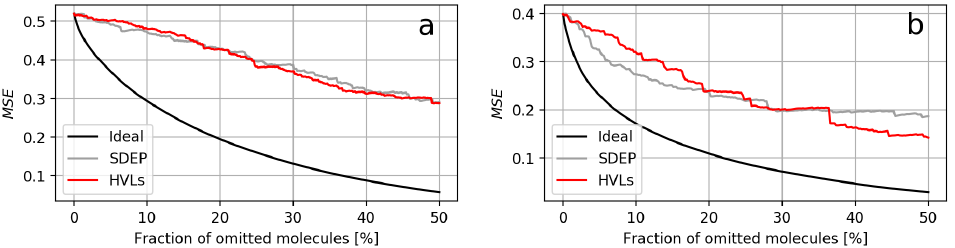
Figure 4. Two confidence curve plots from models using RDKit descriptors. ( a ) Plot of dataset P28335. ( b ) Plot of dataset P49146. Although the area ratios of both UMs in ( a , b ) were close to 1, the confidence curves of the HVLs differed in their shape. In ( a ), both curves progressed in a similar fashion, while in ( b ), the SDEP curve declined faster until the curve of the HVLs sharply decreased after 35% and continued to